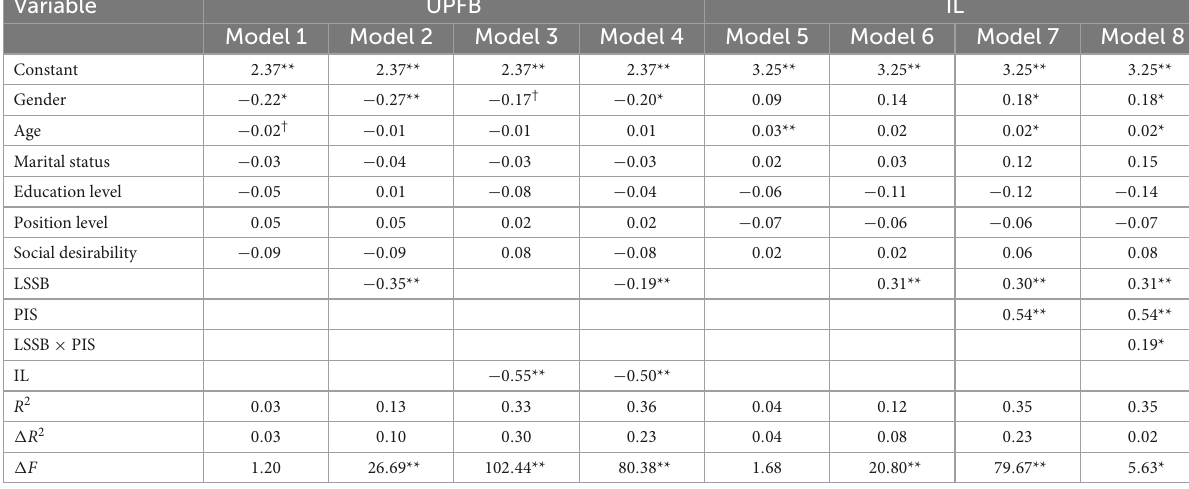
TABLE 3 Hierarchical regression analysis